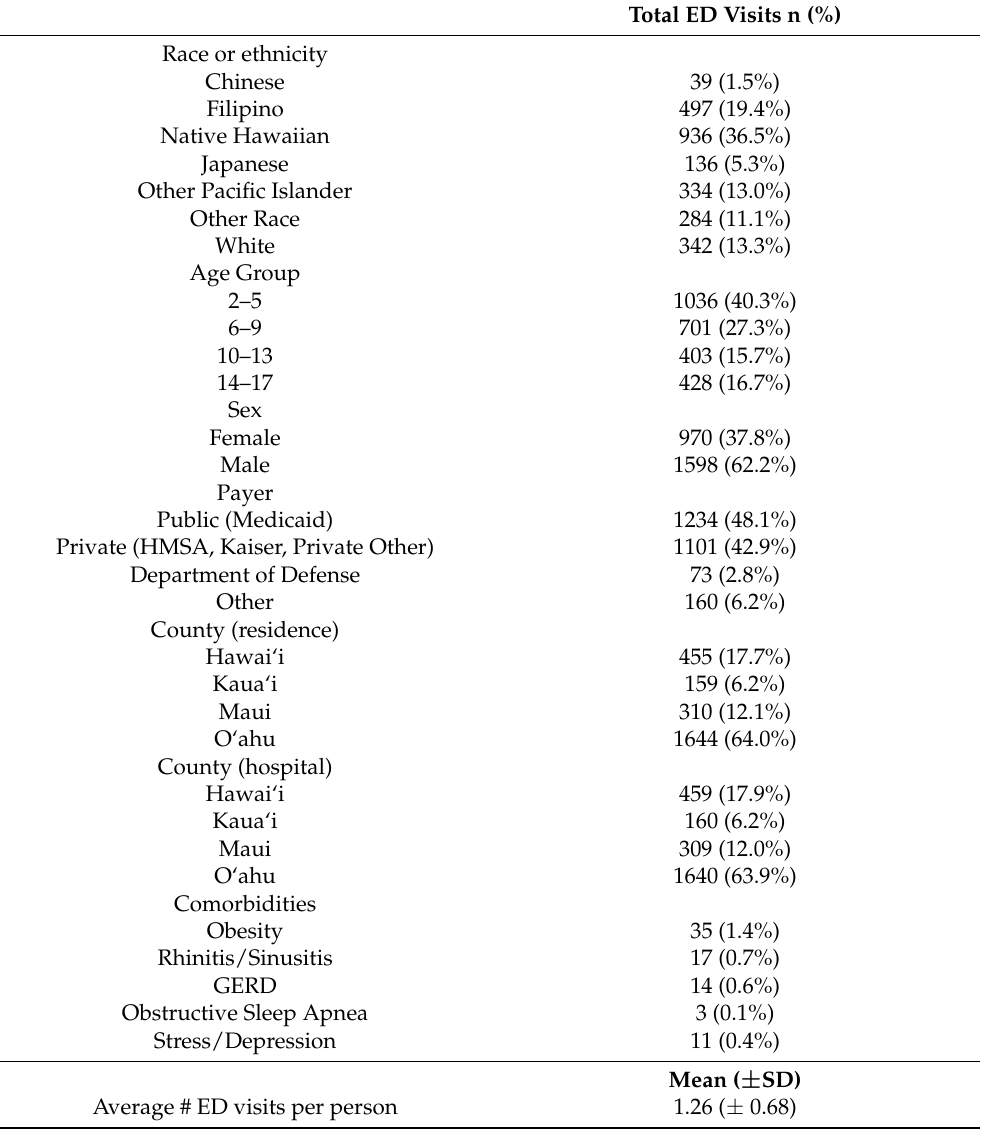
Table 2. Descriptive information for potentially preventable ED visits for pediatric asthma from Hawai‘i Health Information Corporation Data, 2015–2016, using the first visit only (N = 2568). Total ED Visits n (%) Race or ethnicity